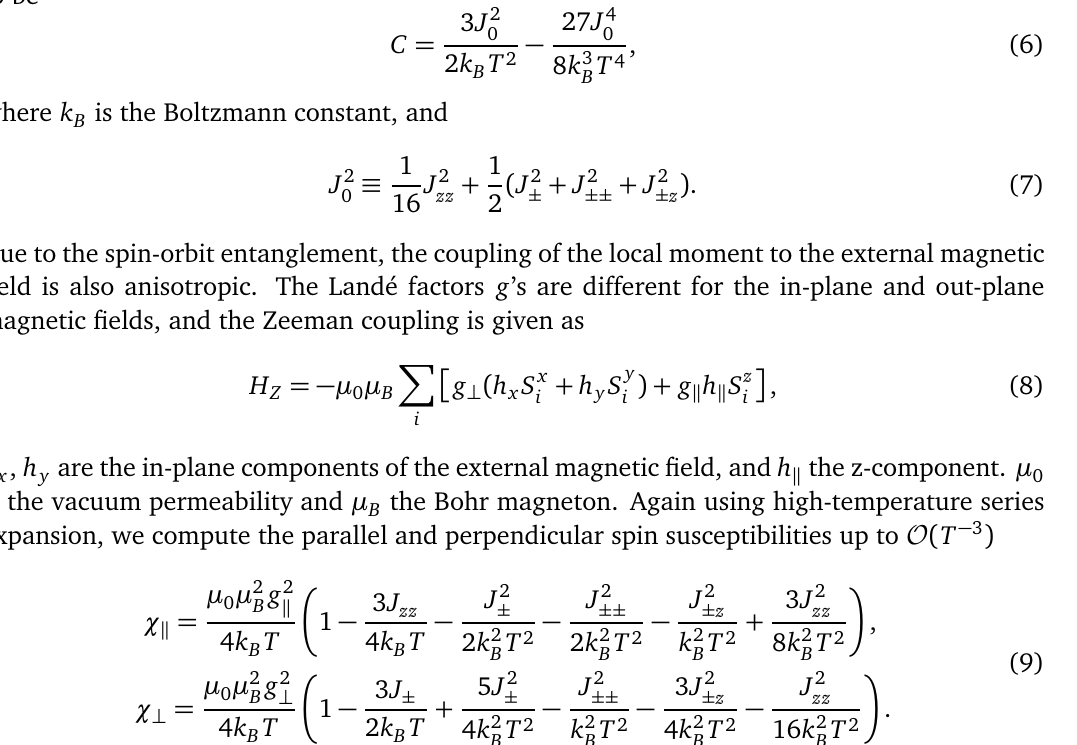
= 1, J = 0.9, J = 0.2, J = 0.1. The susceptibilities in the ± ±± ± z zz µ 2 / 4 k µ 2 / 4 k g 2 g 2 and µ , ⊥ B B 0 0 (cid:107) B B